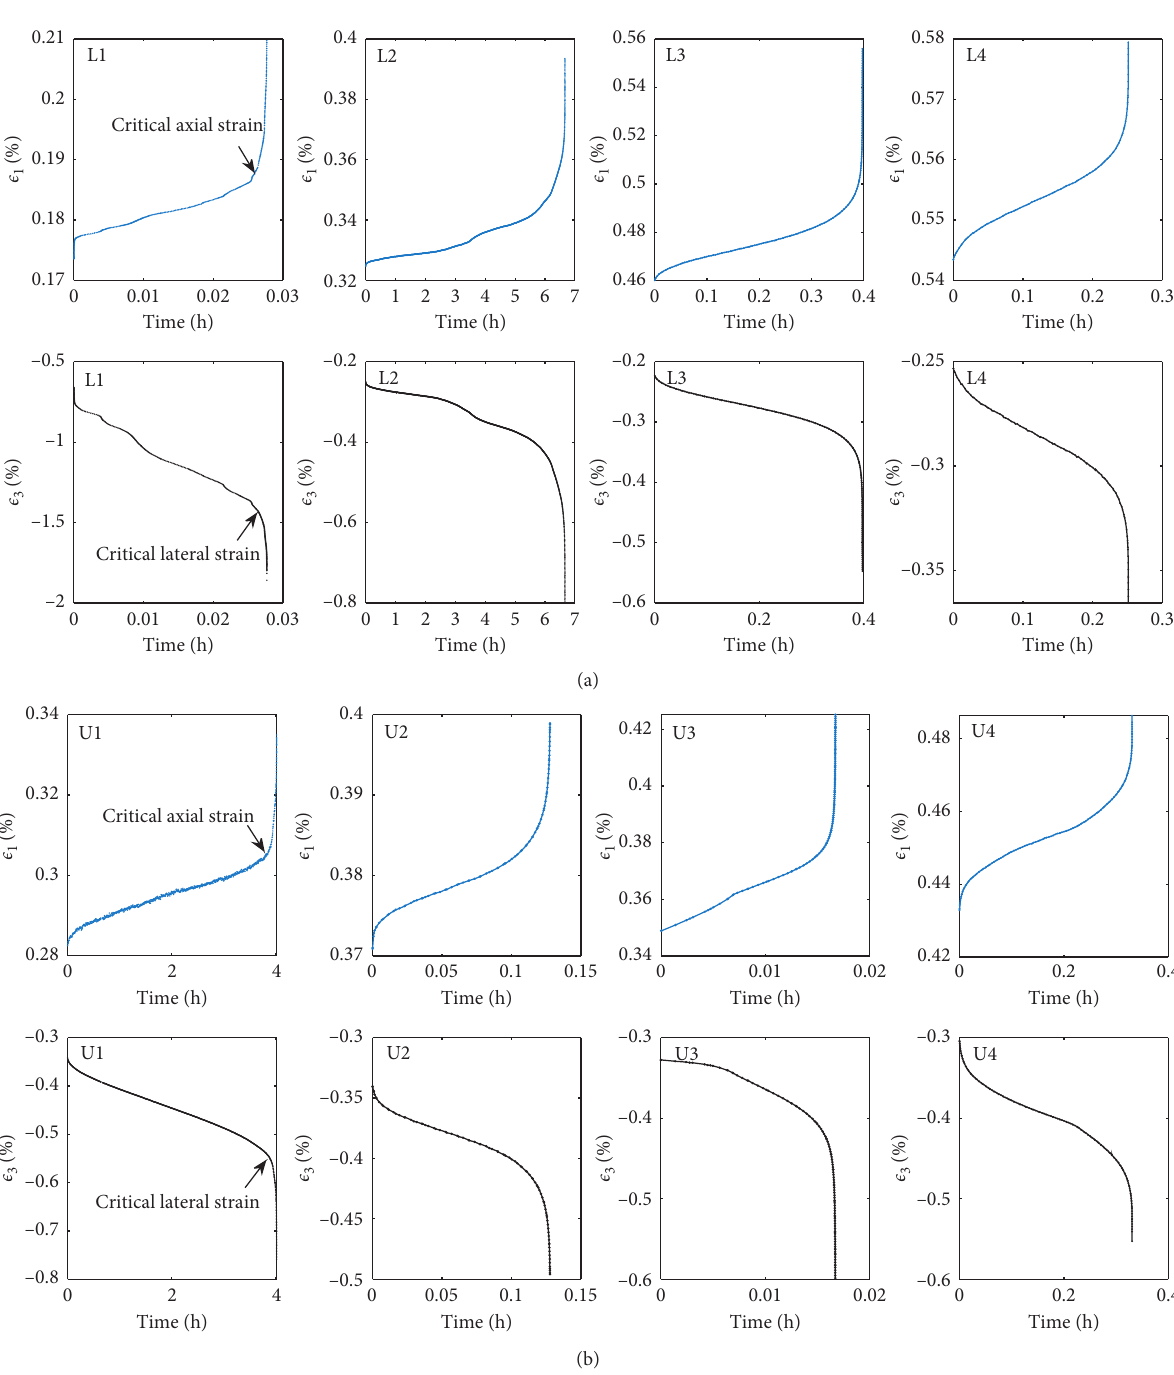
Figure 3: Creep curves of cracked specimens at the last stage of multistage creep test. (a) Loading-cracked samples. (b) Unloading-cracked